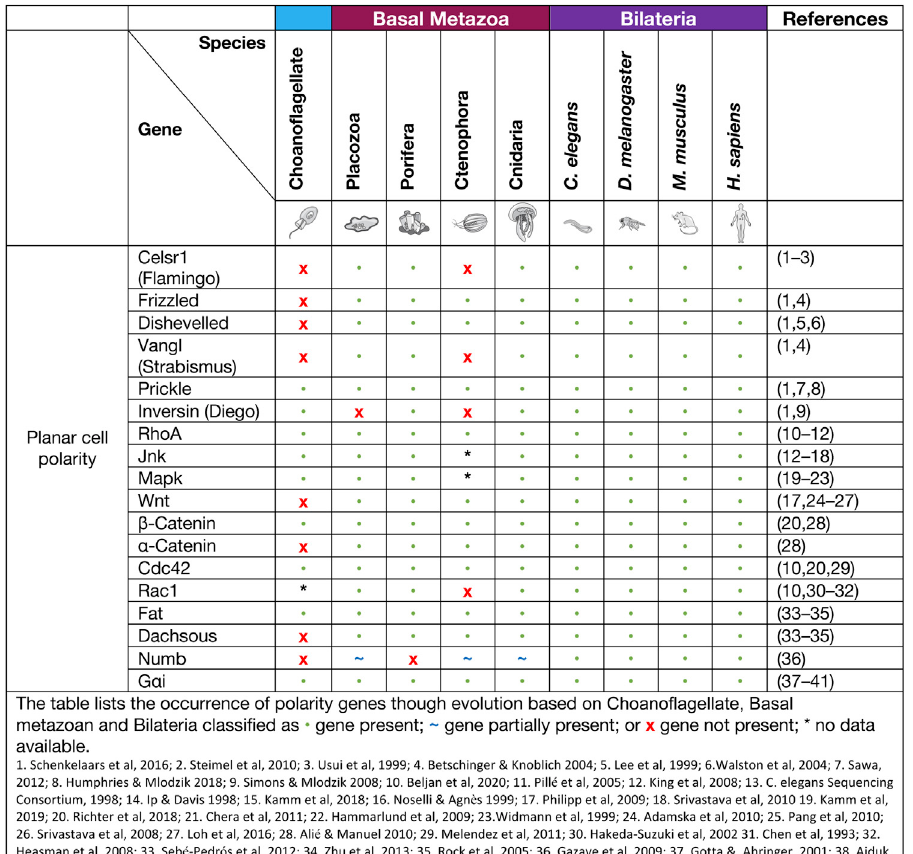
TABLE 2 Planar Cell Polarity